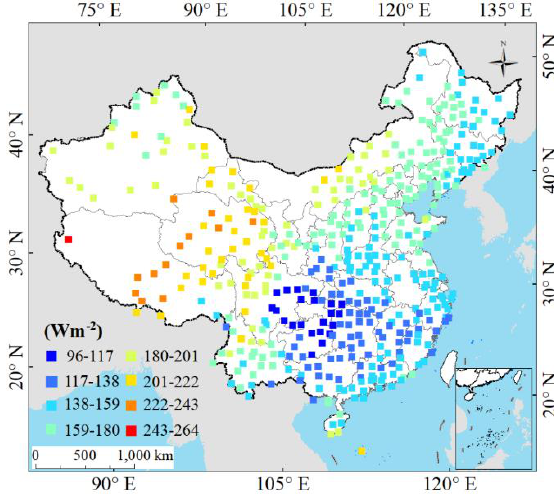
Figure 8. Spatial distribution of the annual mean Rs over China during 1970–2015.